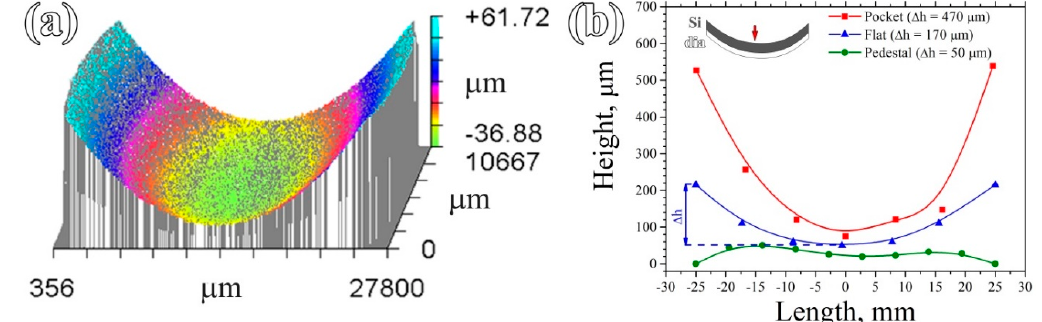
Figure 6. The curvature of the sample grown in pocket-holder taken from the central 1-inch zone from the bottom side ( a ), and the comparison for the whole-plate curvature of all three samples ( b ). Displacement of the plates is shown in ( b ) as h. Lines are guides for the eye.